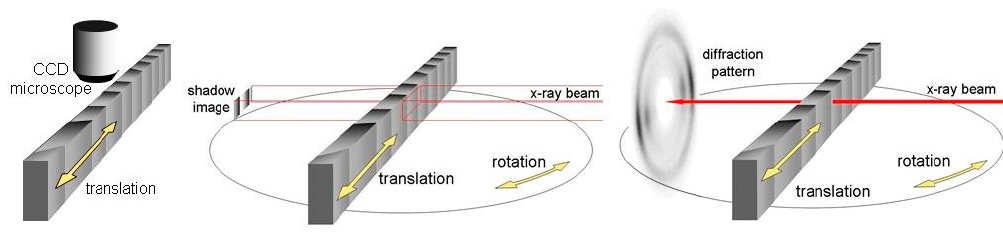
Figure 8. The three analysis components of SilviScan (Cell Scanner, Densitometer, Diffractometer).